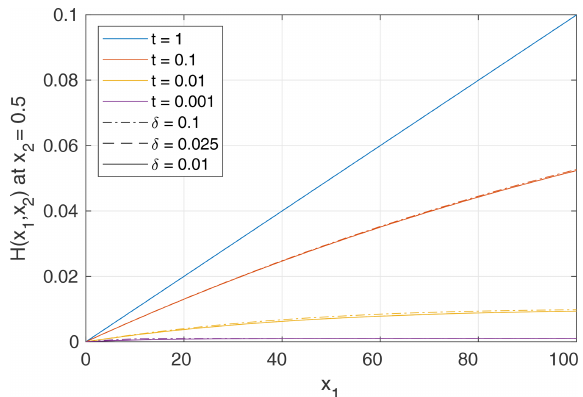
Figure 9. Numerical results for the scenario considered in Fig. 3. The river profiles obtained for δ = 0 . 025 and δ = 0 . 01 cannot be distinguished visually.